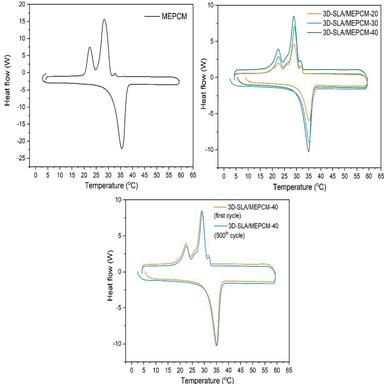
The DSC thermographs illustrating the thermal behavior of the pure MEPCM, 3D-SLA/MEPCM composites and 3D-SLA/MEPCM-40 samples with 500th cycles.